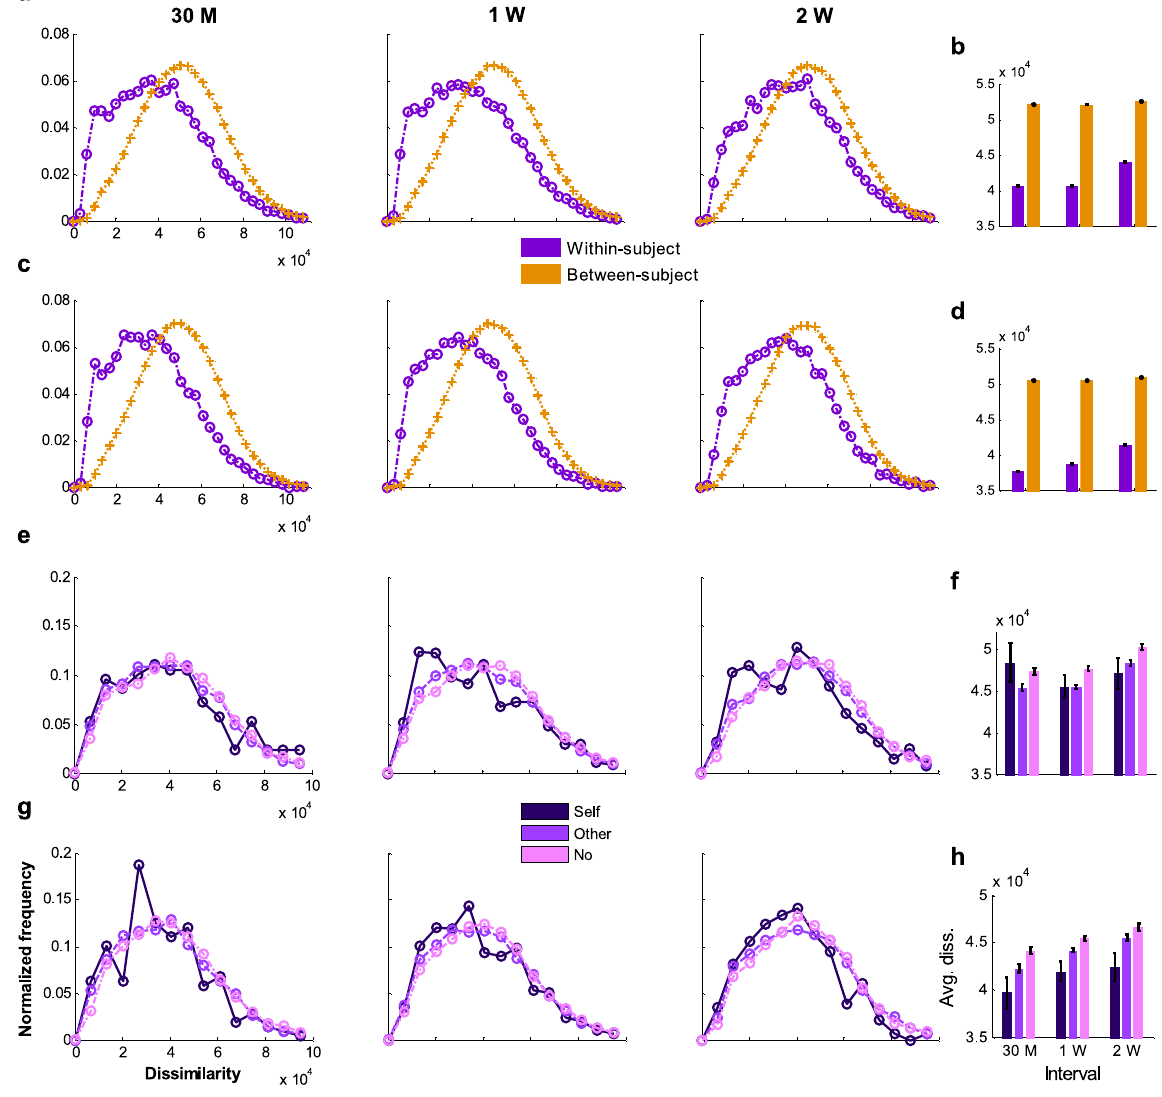
Figure 4. Distributions of scanpath dissimilarity values. The frequency distributions of within- and between-subject scanpath pairs plotted according to the dissimilarity values for ( a ) Free (the number of valid within-subject pairs: n 30M = 7,122, n 1W = 18,857, and n 2W = 9,650 and between-subject pairs: n 30M = 357,727, n 1W = 471,825, and n 2W = 243,674) and ( c ) Task sessions (the number of valid within-subject pairs: n 30M = 7,009, n 1W = 18,451, and n 2W = 9,601 and between-subject pairs: n 30M = 352,705, n 1W = 464,890, and n 2W = 240,604). ( b ) The overall mean dissimilarity of each distribution in ( a ) and ( d ) that of each distribution in ( c ). ( e ) The frequency distributions of within-subject scanpath pairs plotted according to the dissimilarity values of each trial group for Free (the number of pairs from the self-face group: n 30M = 195, n 1W = 518, and n 2W = 260, from the other-face group: n 30M = 3,725, n 1W = 9,872, and n 2W = 5,022, and from the no-face group: n 30M = 3,202, n 1W = 8,467, and n 2W = 4,368) and ( g ) Task sessions (the number of pairs from the self-face group: n 30M = 190, n 1W = 505, and n 2W = 264, from the other-face group: n 30M = 3,668, n 1W = 9,658, and n 2W = 5,012, and from the no-face group: n 30M = 3,151, n 1W = 8,288, and n 2W = 4,325). ( f ) The overall mean dissimilarity of each distribution in ( e ) and ( h ) that of each distribution in ( g ). The sum of each distribution is 1. The error bars in ( b ), ( d ), ( f ), and ( h ) represent standard